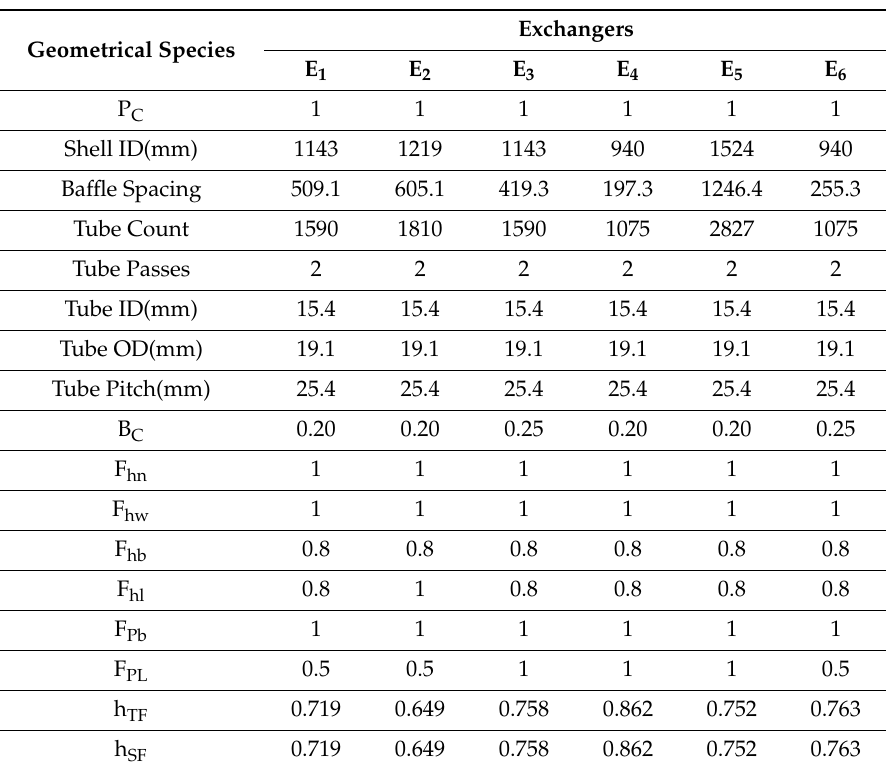
Table A2. Heat exchangers’ specifications for heat exchanger networks (HEN) of crude oil pre-heat train.